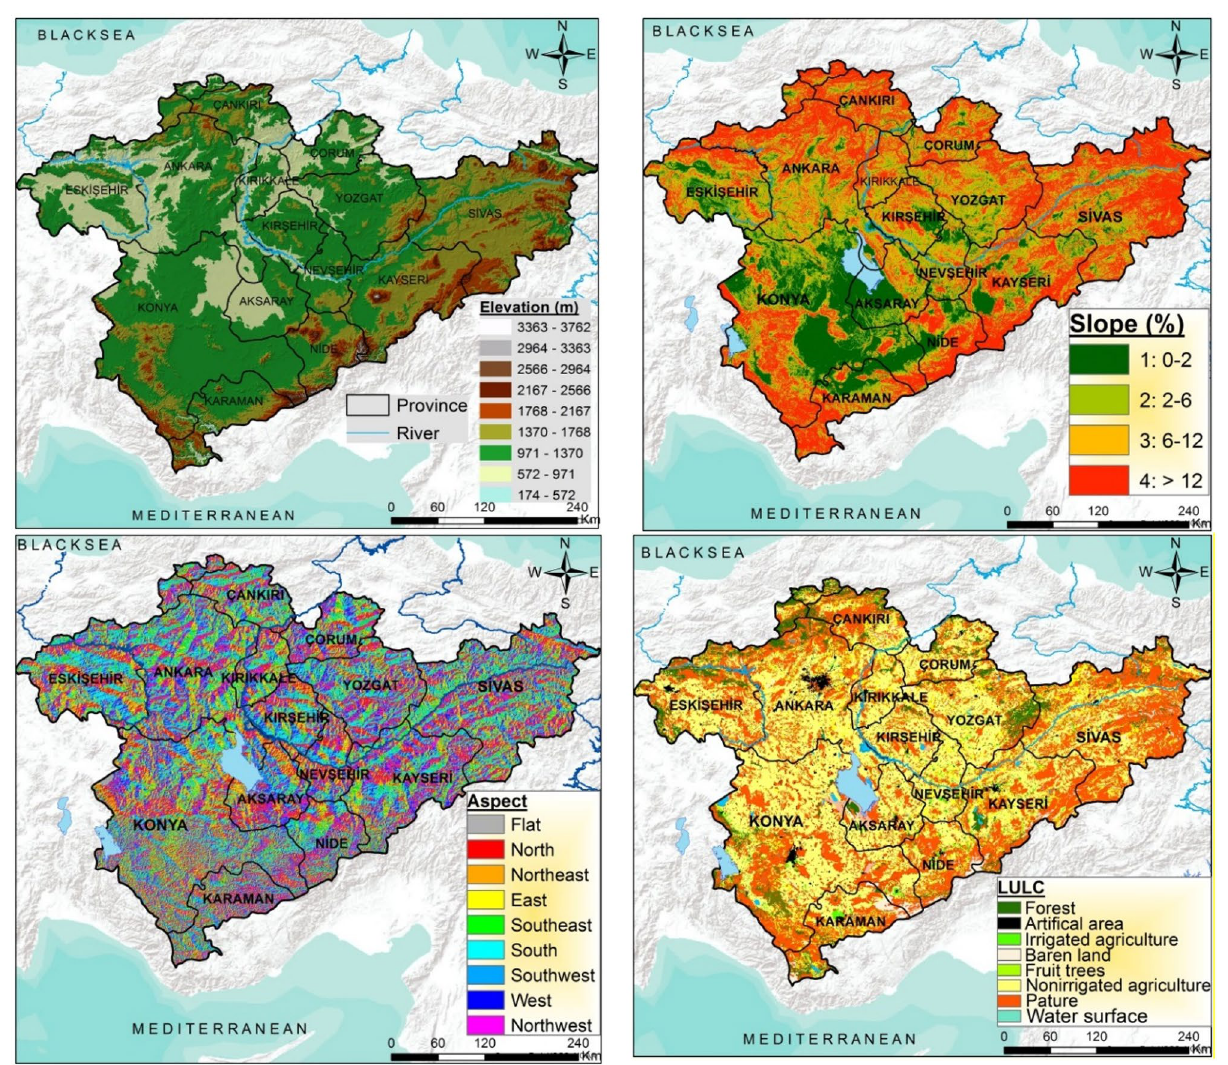
Figure 2. Elevation, slope, aspect and land cover-land use maps of the Central Anatolia Region (the maps were created by the authors using the ArcGIS 10.2,